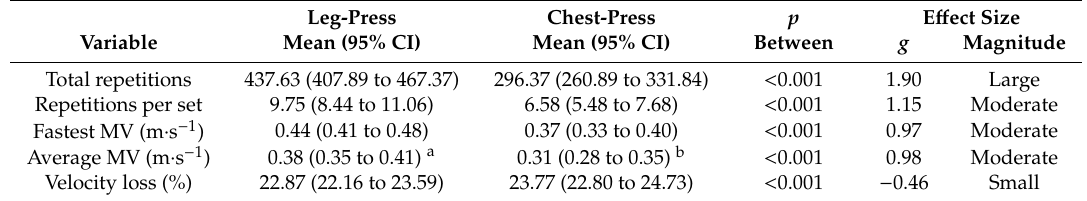
Table 4. Overall description of the acute training variables in the leg-press and chest-press exercises.